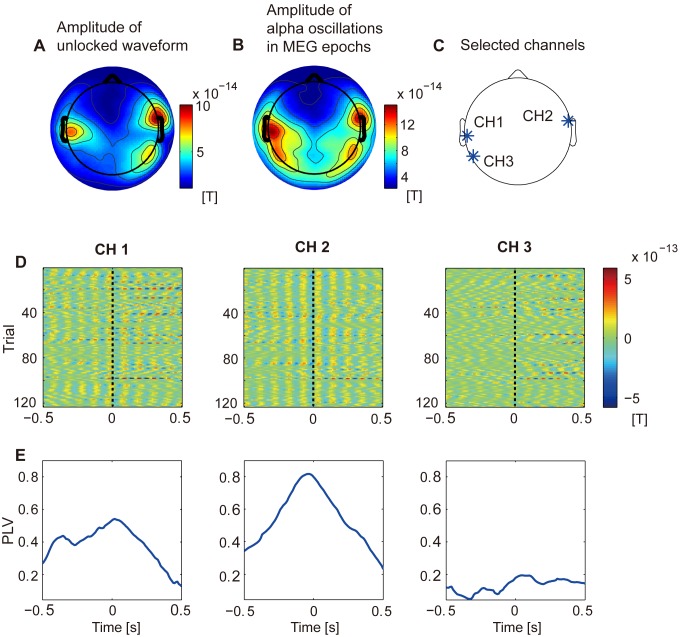
Relation between unlocked waveform and alpha oscillations in MEG epochs during Go condition (subject 8).
A: Amplitude distribution over space of unlocked waveform. B: Amplitude distribution over space of alpha oscillations in MEG epochs. C: Selected channels: CHs 1–3. At CHs 1 and 2, unlocked waveform and alpha oscillations in MEG epochs have large amplitudes in common. At CH 3, alpha oscillations in MEG epochs have large amplitudes but unlocked waveform does not. D: Time-trial images of alpha oscillations in MEG epochs at CHs 1–3. Vertical dotted lines represent peak time of unlocked waveform. E: PLVs at CHs 1–3. In D and E, time 0 corresponds to peak of unlocked waveform. Other subjects show similar results.